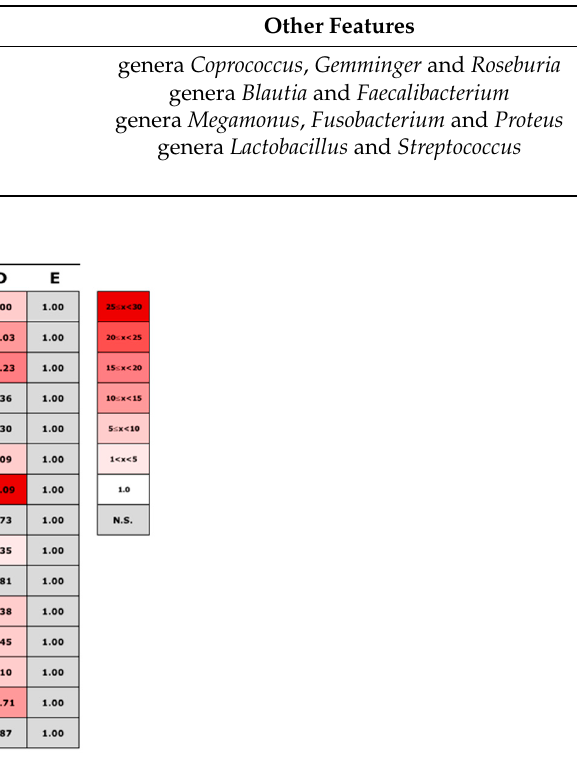
Table 3. Summary of taxonomic features characteristically rich in gut microbiota of each PAM- identified type.